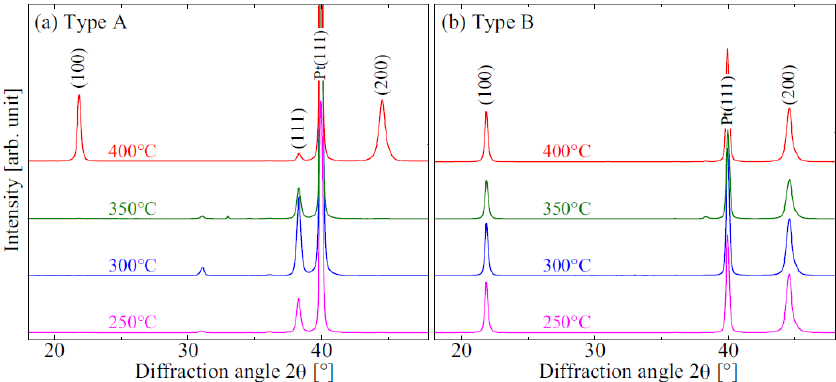
Figure 2. XRD patterns of the prepared PZT films through ( a ) type-A annealing schedule (320 nm-interface layer) and ( b ) type-B annealing schedule (60 nm-interface layer).